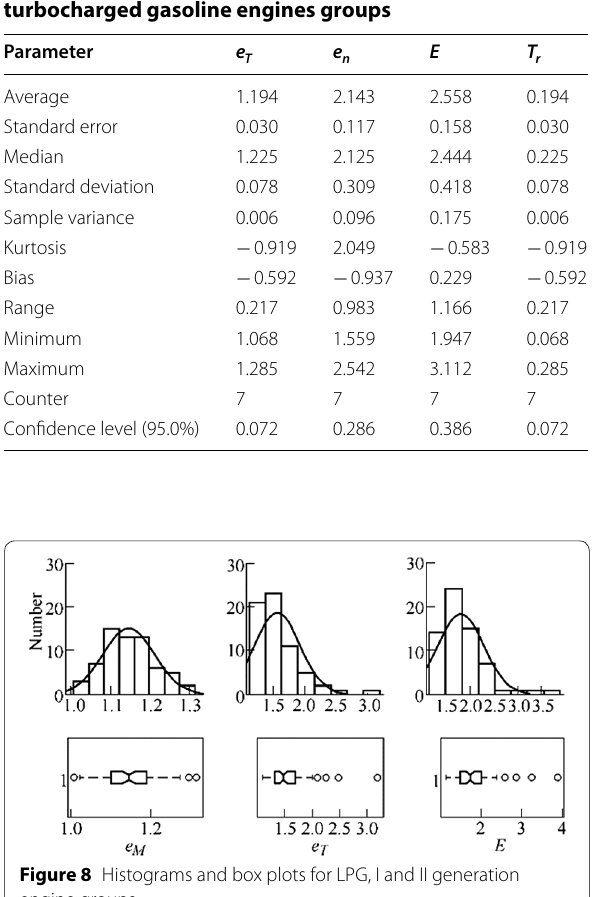
Table 7 Results of the calculations for fuel injected,